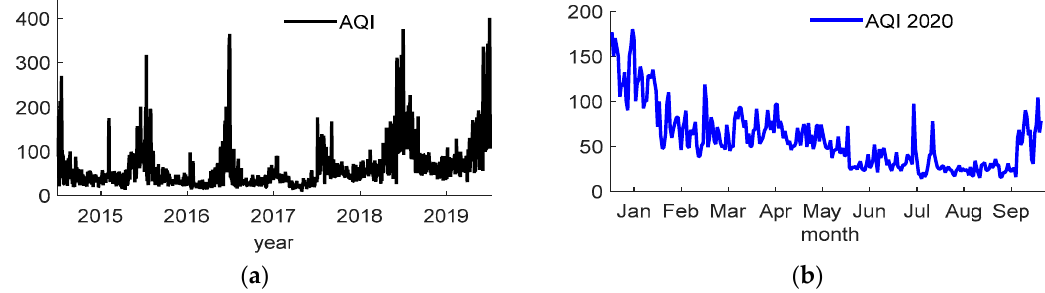
Figure 6. ( a ) AQI from 2015 to 2019, ( b ) AQI for 2020 for months from January to October.